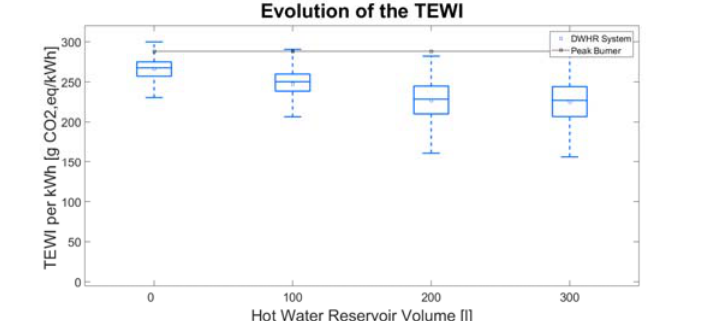
Figure 6. Evolution of the Total Equivalent Warming Impact per kWh with hot wat reservoir